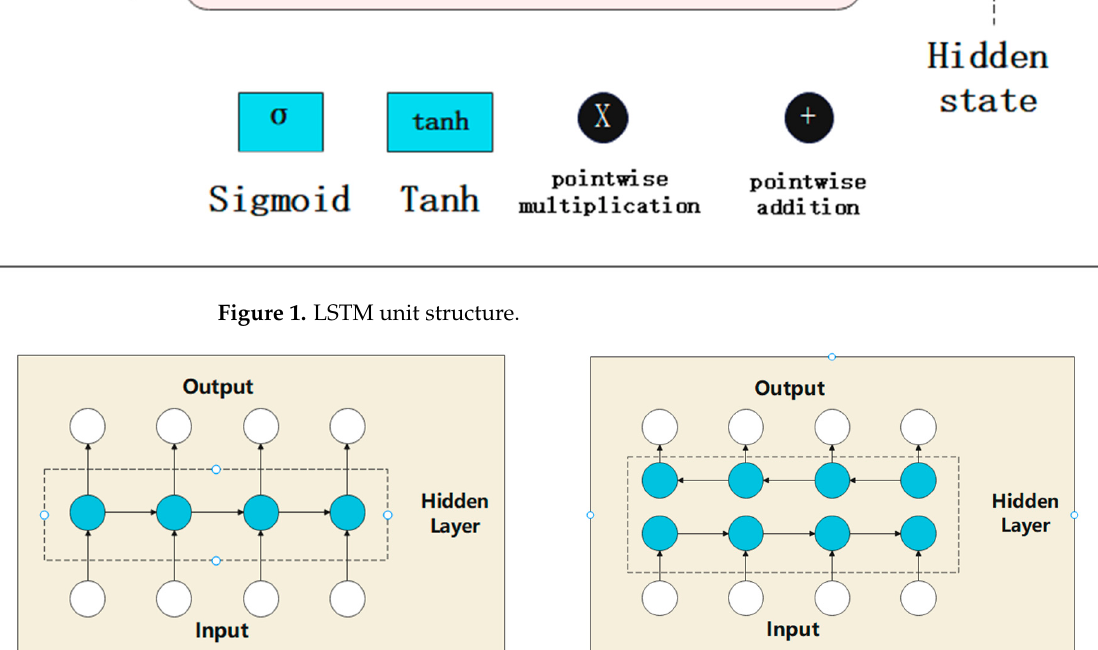
Figure 2. LSTM architecture vs. Bi-LSTM architecture.